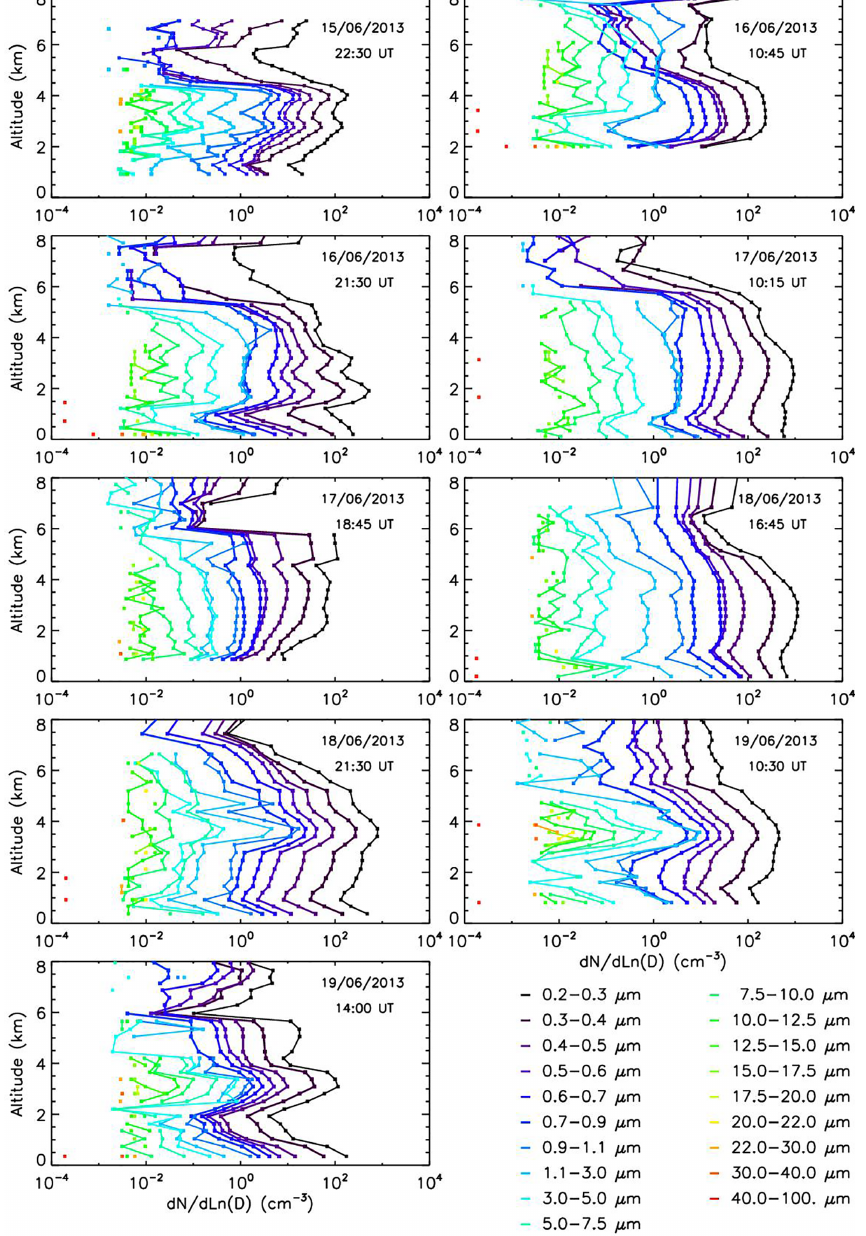
Figure 7. Evolution of the dust plume from LOAC balloon measurements over Minorca, Spain, from 15 to 19 June. The ascent from 0 to 8km takes about 30min and the reported times of measurement are taken at the middle of the